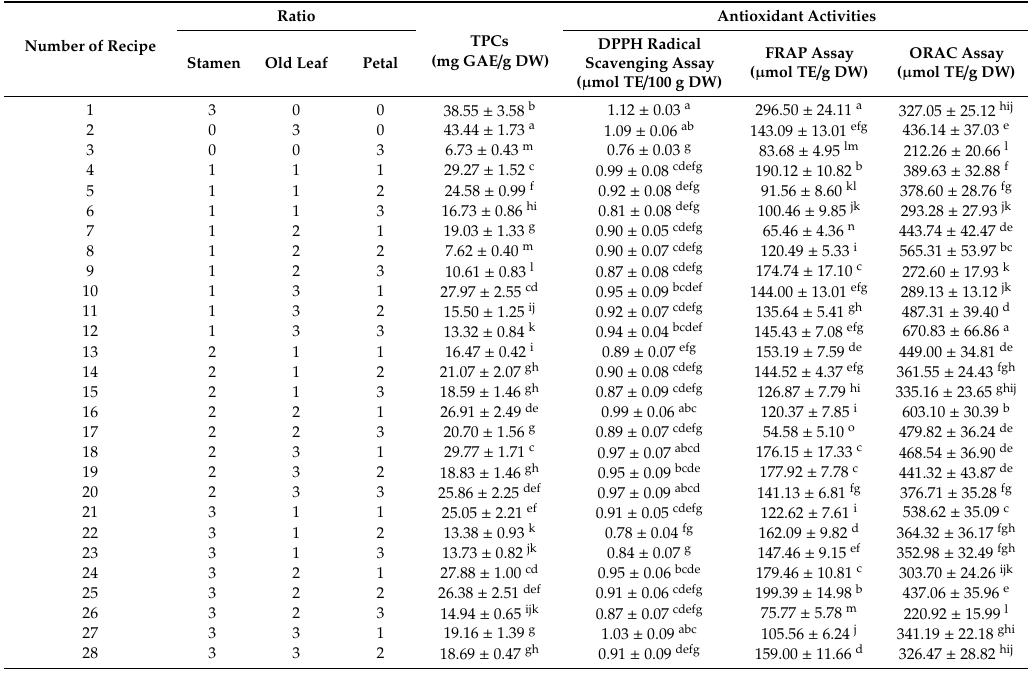
Table 6. Antioxidant activities and total phenolic contents (TPCs) of di ff erent mixtures (ratios) of stamen, old leaf, and petal of sacred lotus ( Nelumbo nucifera